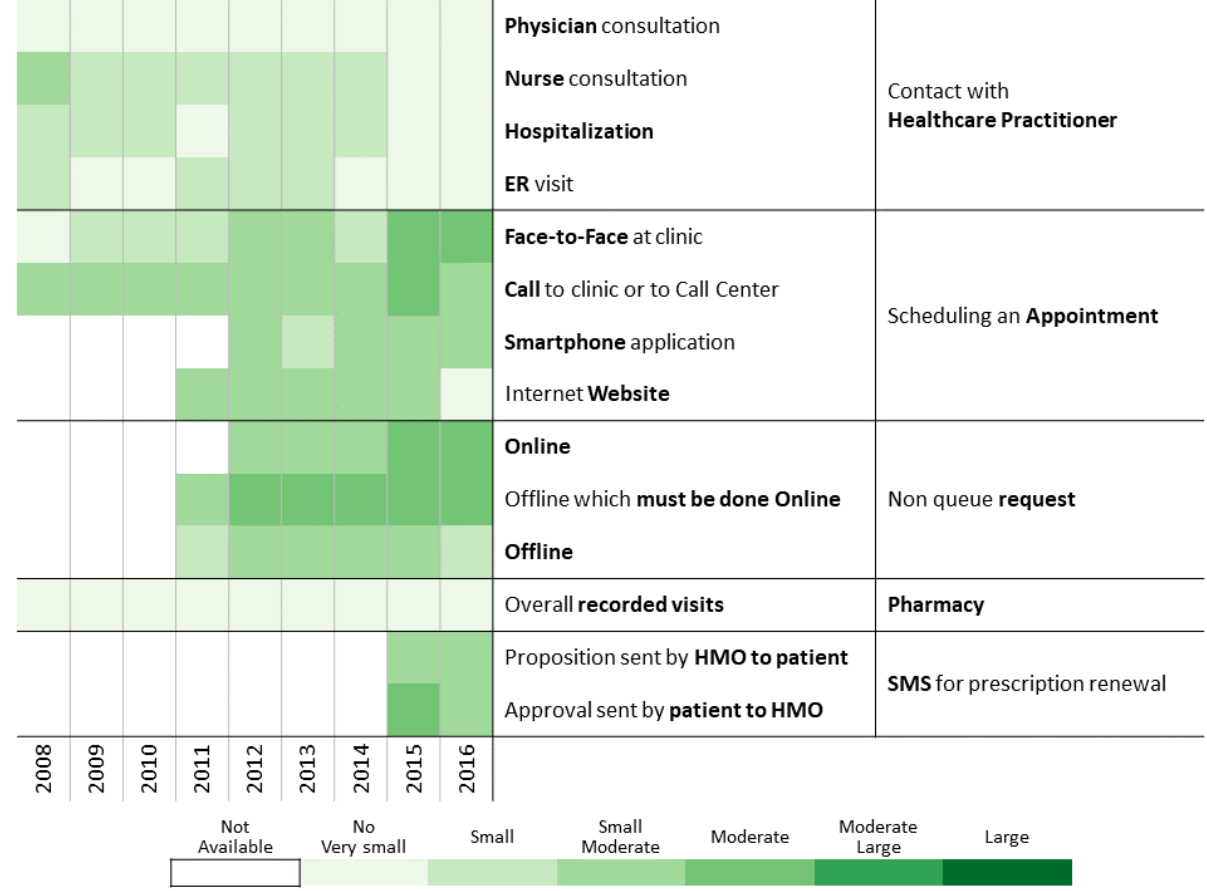
Figure 9. Communication patterns for patients having a low number but scheduled visits and preferring communication channels that do not involve a face-to-face